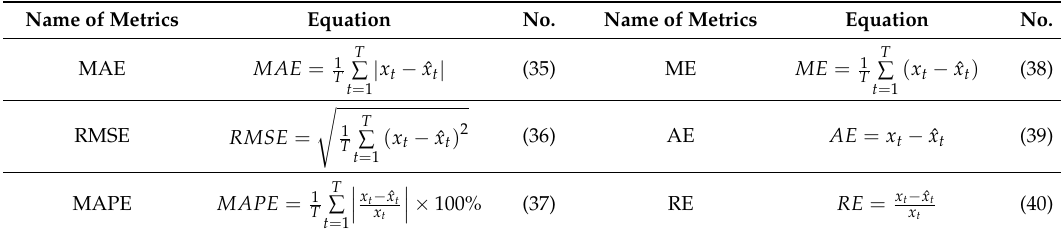
Table 1. The evaluation